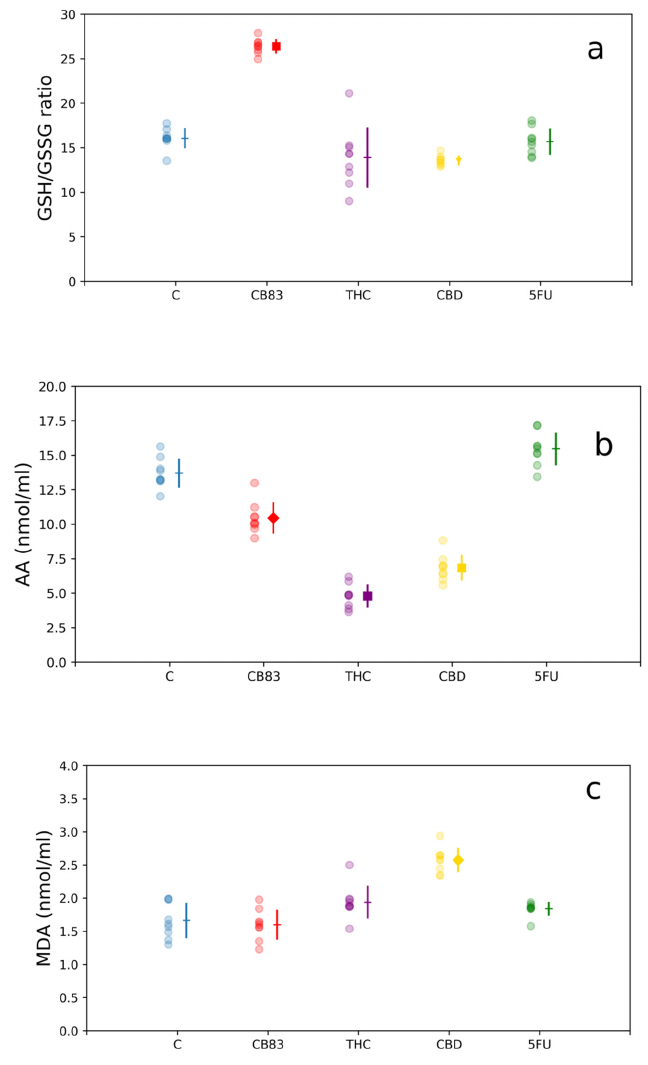
Figure 3. Nonenzymatic antioxidant contents: ( a ) glutathione / oxidized glutathione (GSH / GSSG) ratio, ( b ) ascorbic acid (AA) levels, and ( c ) malondhyaldhehyde (MDA) levels in HT-29 cells exposed to IC50 of CB83, THC, CBD, and 5-Fluorouracil (5FU). Data are representative of three independent experiments. For each treatment, the experimental measurements (left side with circle marker) and mean values ± S.D. (right side) are reported. Mean value markers represent the significance vs. control (C): triangle for p < 0.05, diamond for p < 0.01, and square for p < 0.001; hyphen if dataset is not significant.